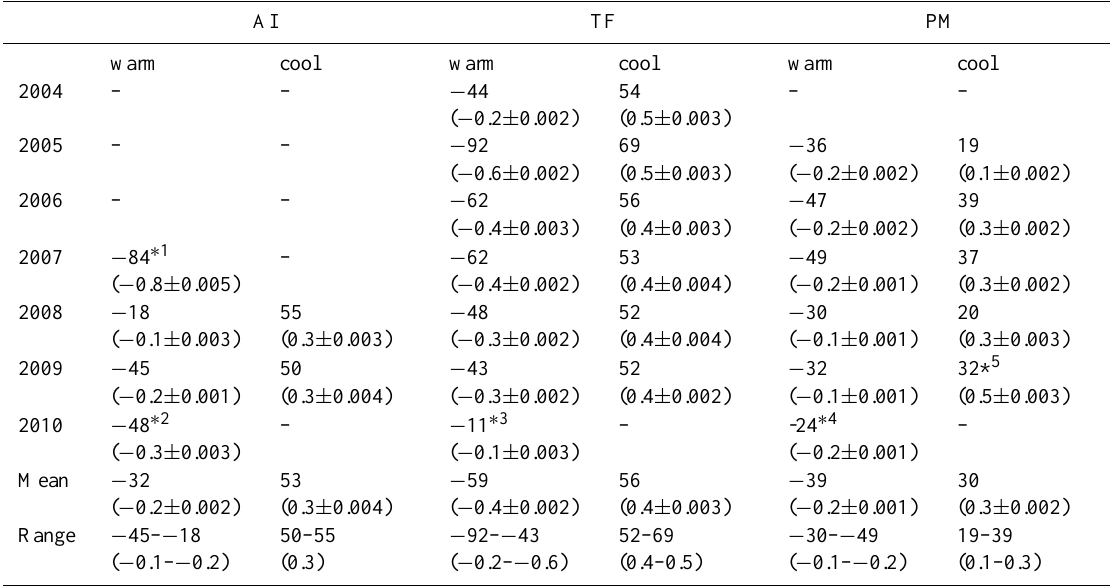
Table 1. The total decrease and increase (ppqv) of Hg 0 as well as its decline and increase rates (ppqvd − 1 ± standard error, in parentheses) during the warm and cool seasons at AI, TF, and PM. The asterisks denote the seasons that were shorter due to missing measurement data and/or shortened study periods. The mean values and ranges did not include the values with asterisks. AI